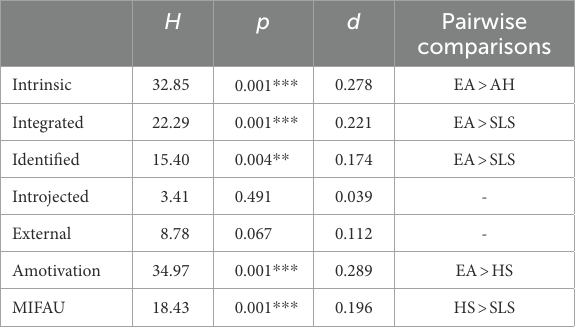
TABLE 4 Inferential results of the regulation of motivation and intention to be physically active as a function of the field of study. H p d Pairwise